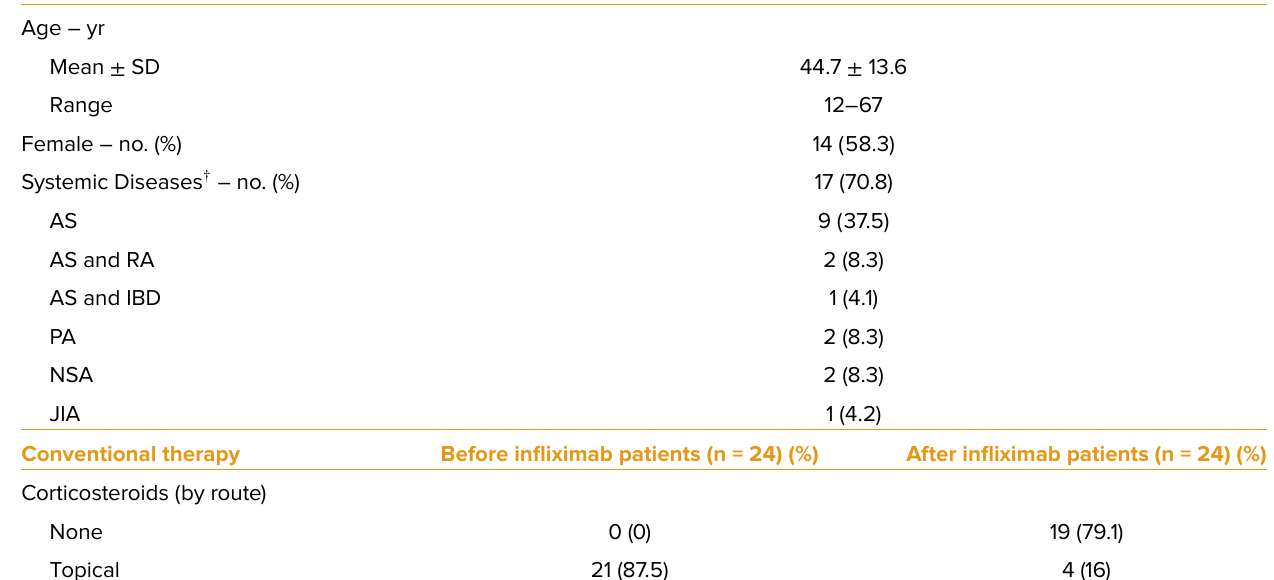
Table 1. General characteristics and medication